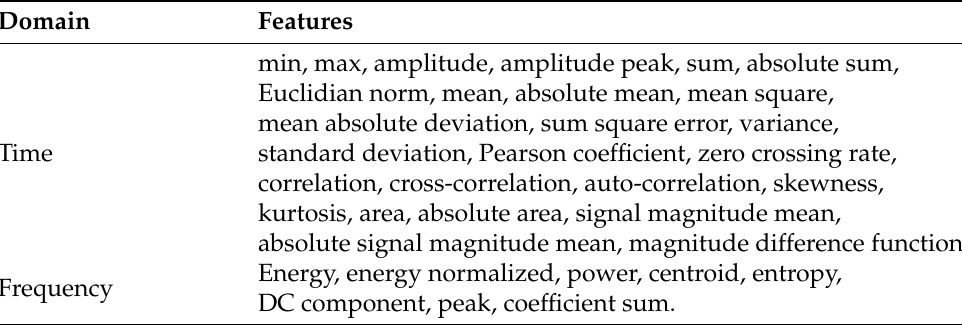
Table 3. List of all features used in the experiments with the baseline classifiers.